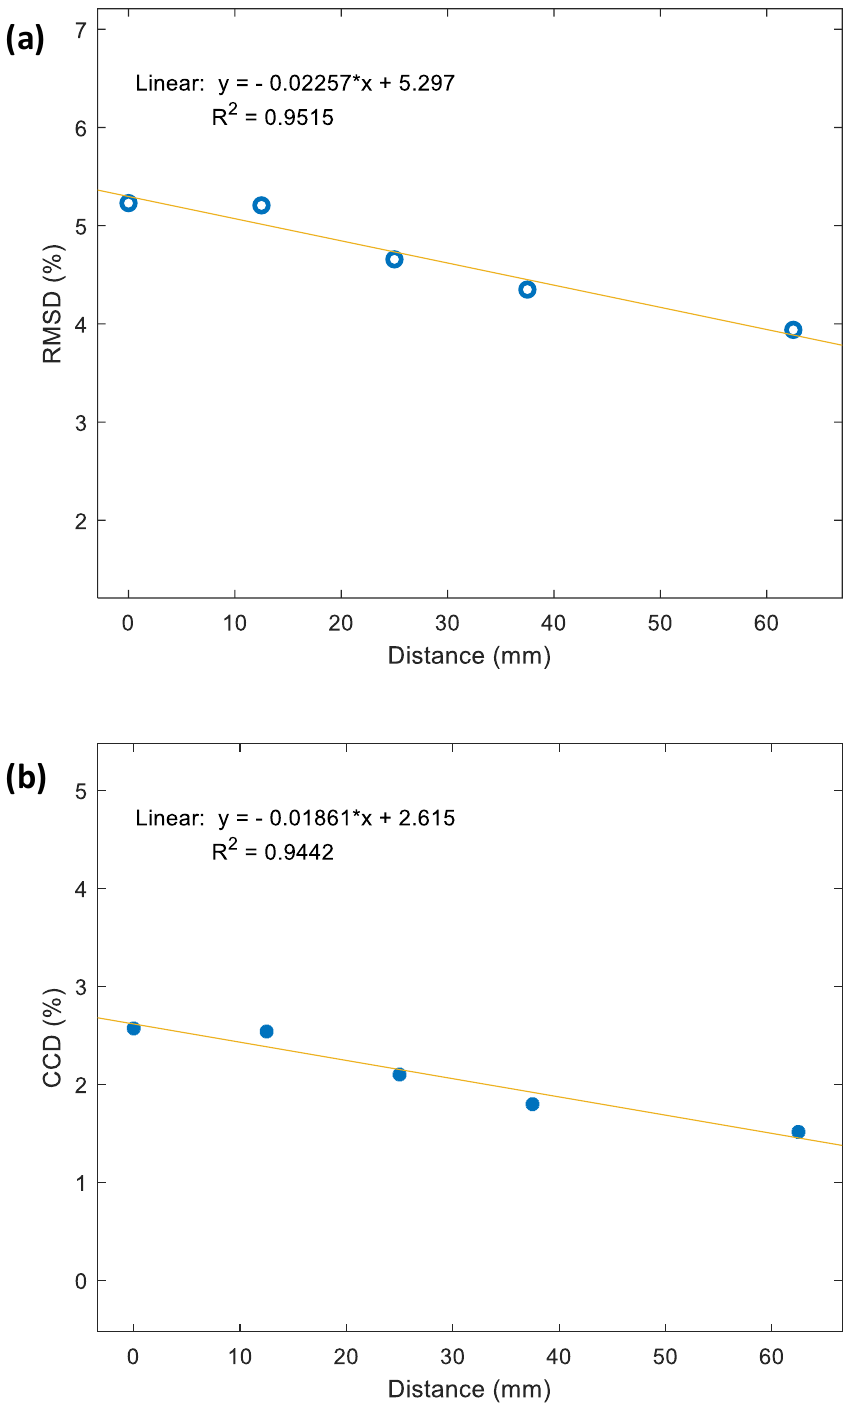
Figure 11. Linear regression analyses of the damage metric vs. the distance ( y ) for the horizontal cracks: ( a ) RMSD metric; ( b ) CCD metric.